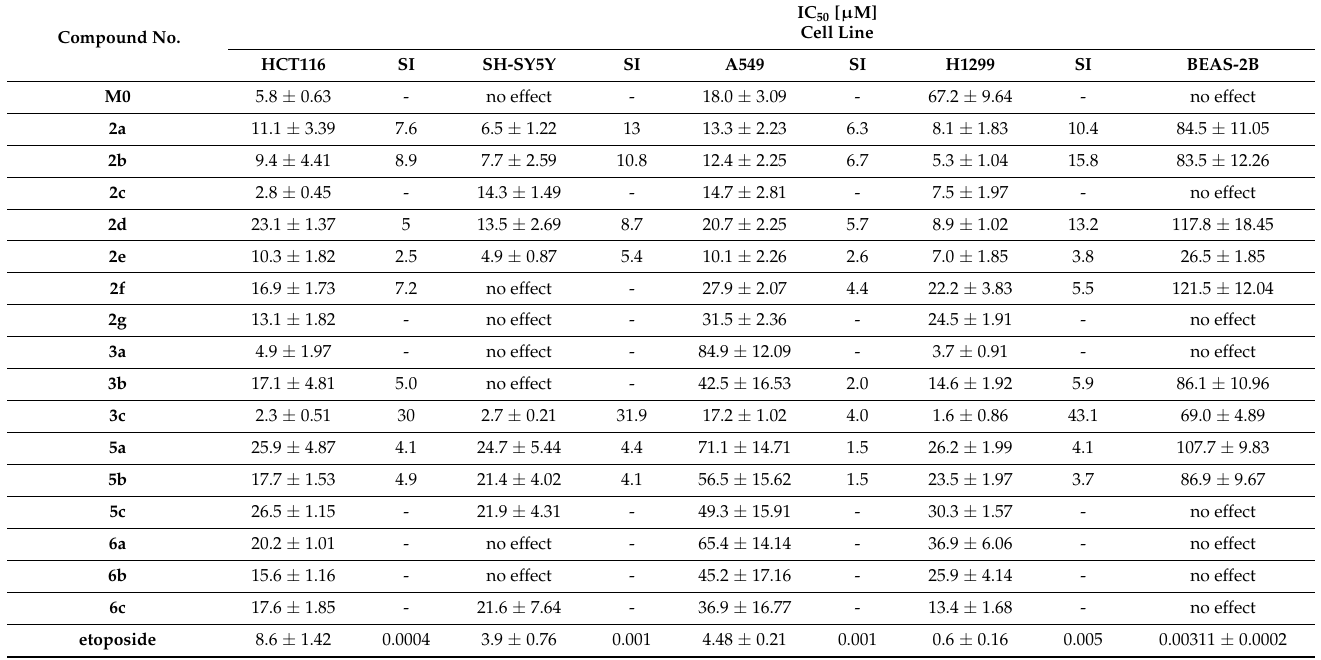
Table 1. IC 50 calculated for HCT116, SH-SY5Y, A549, H1299, and BEAS-2B cell lines after 72 h of incubation with tested compounds (mean value from 3 experiments +/ −